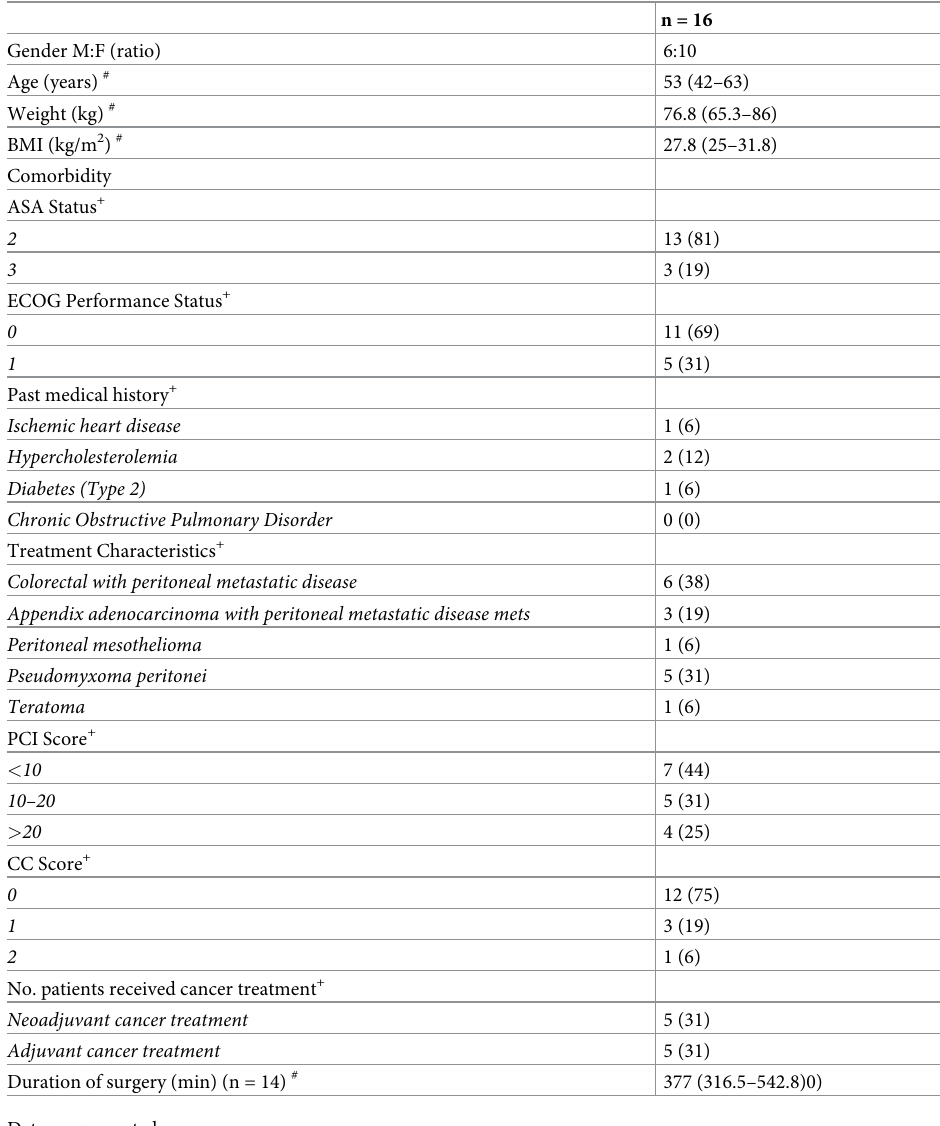
Table 1. Participant